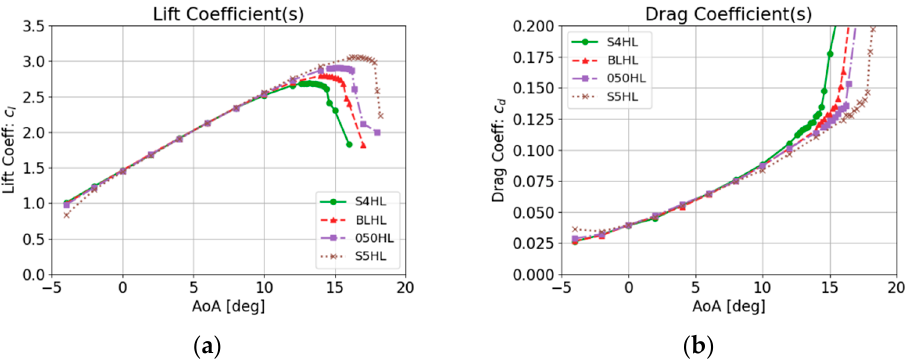
Figure 4. Calculated lift ( a ) and drag ( b ) coefficients for high-lift profiles. Table 1. List of maximum lift coefficients and stall angles. Profiles